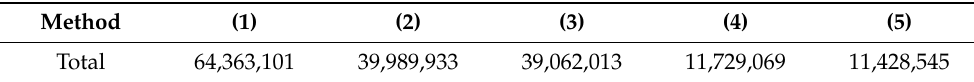
Table 3. Total net parameter.